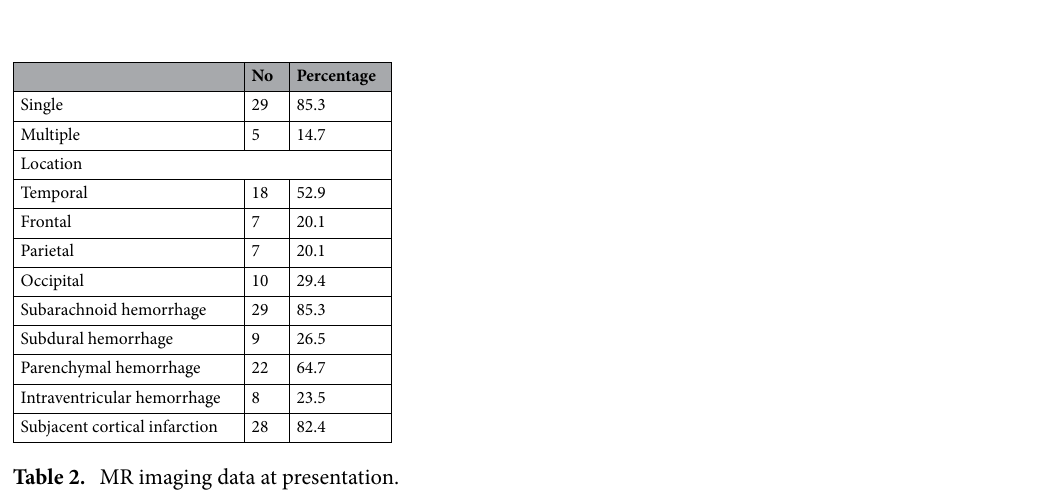
Table 2. MR imaging data at